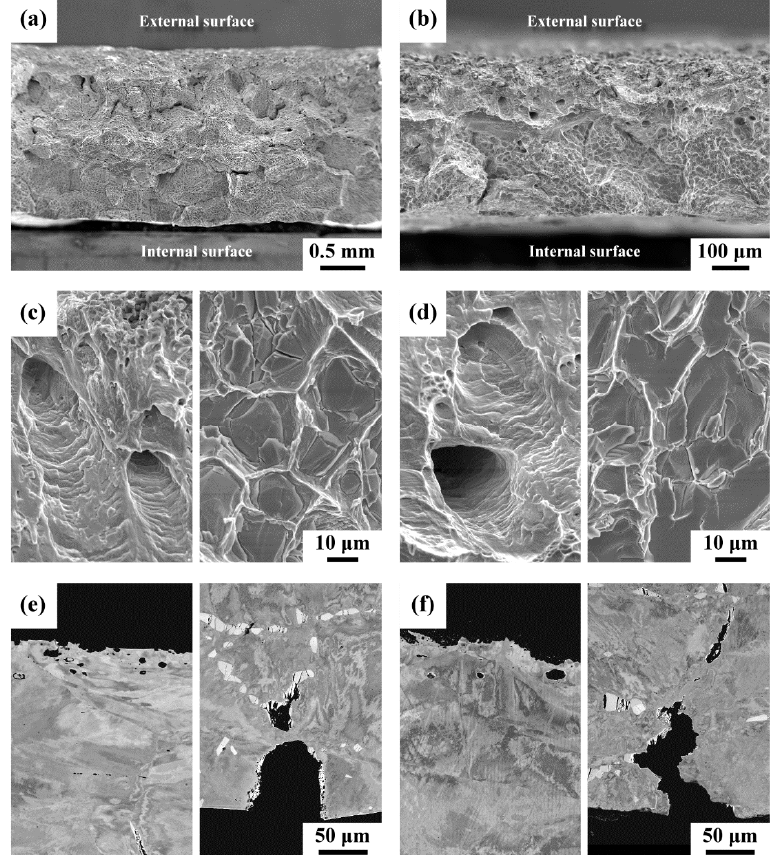
Figure 8. SEM micrographs showing the tensile fracture morphology and microstructure of the ( a , c , e ) thick sample and ( b , d , f ) thin sample: ( a , b ) the macro-fracture appearance; ( c , d ) the micro-fracture feature; ( e , f ) the microstructure around the tensile fracture zone. The left-hand image in ( c – f ) photos from around the outer surface and right-hand image in ( c – f ) photos from around the inner surface.